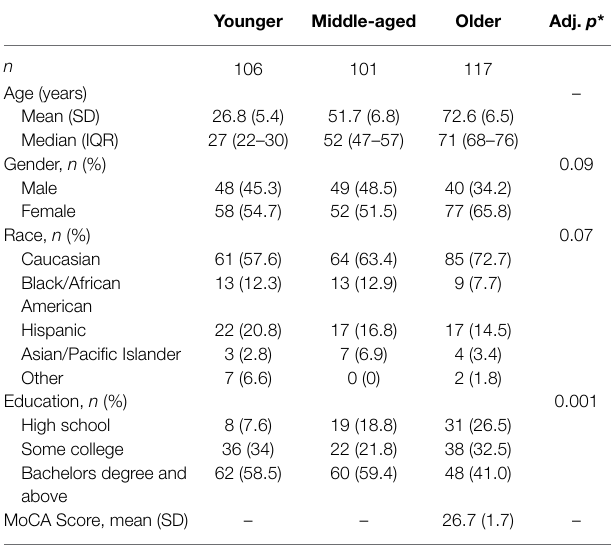
TABLE 1 | Demographic characteristics of adult participants by age